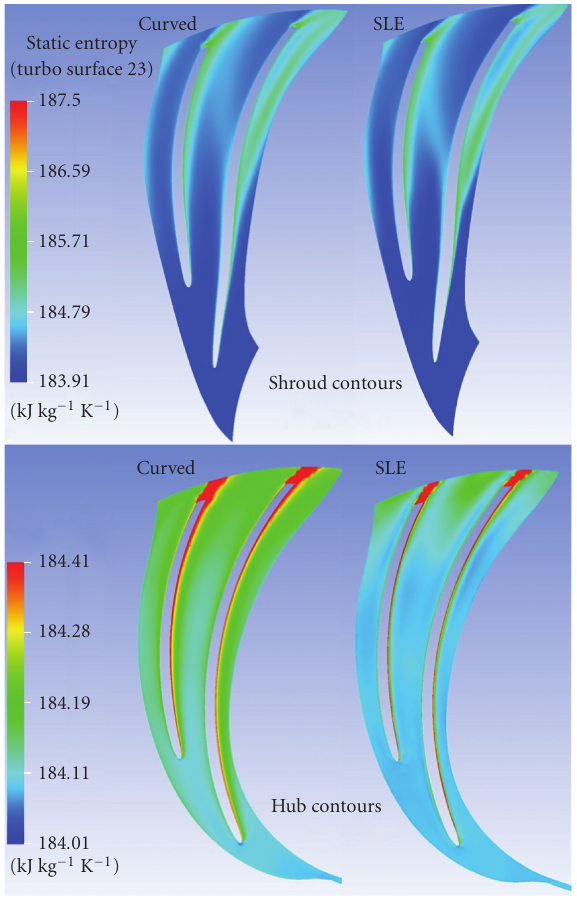
Figure 8: Static entropy contours along constant spanwise position at 5% and 95% of spanwise distance at flow factor of 0.0713 (scale was upper bounded at 184.41 KJ/kg ·